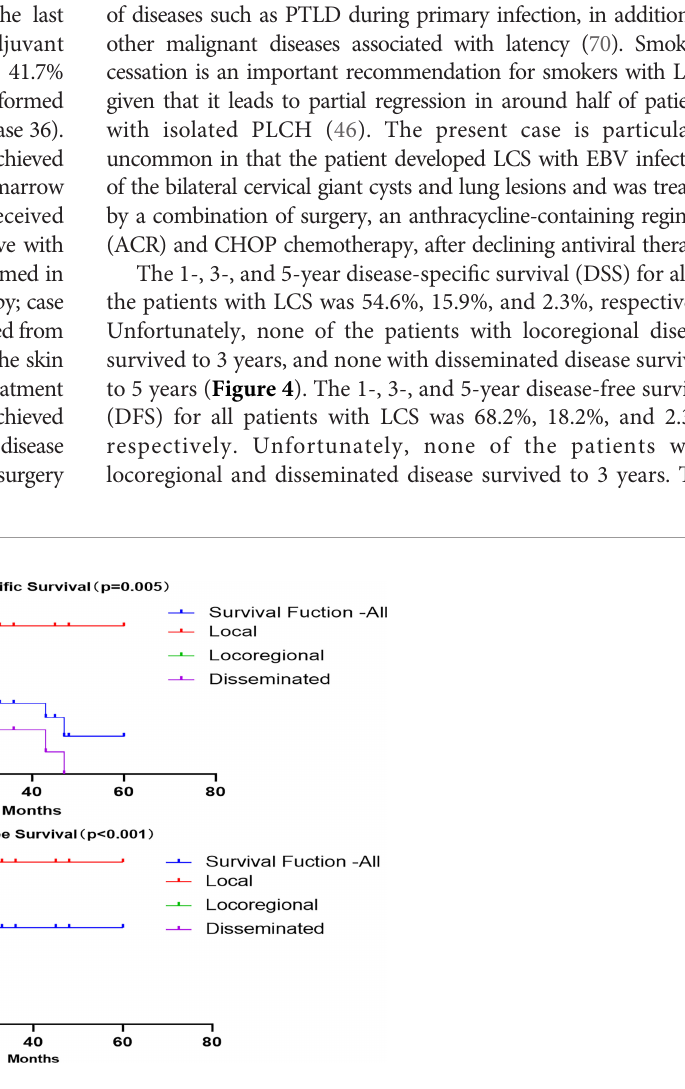
FIGURE 4 | Kaplan – Meier survival